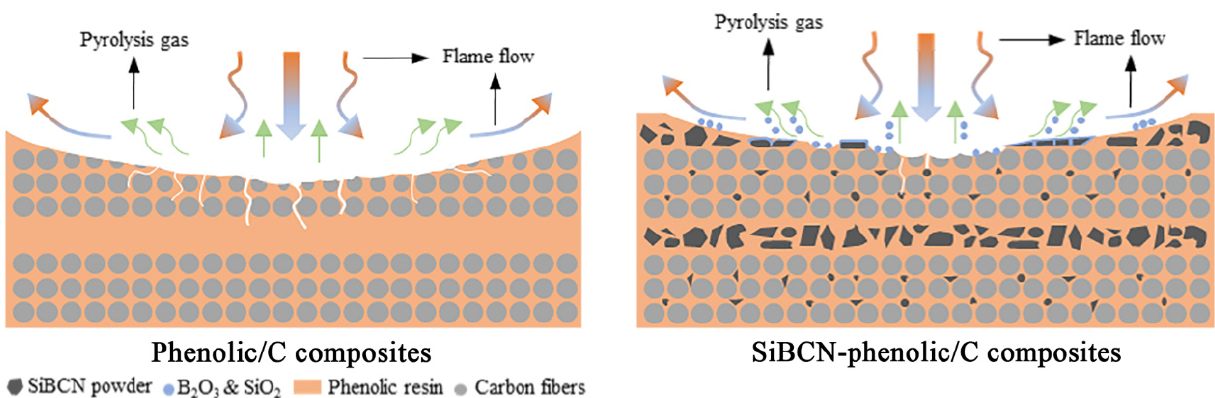
Figure 12. Diagram of the ablation resistance mechanism of the phenolic/C composites and the SiBCN–phenolic/C